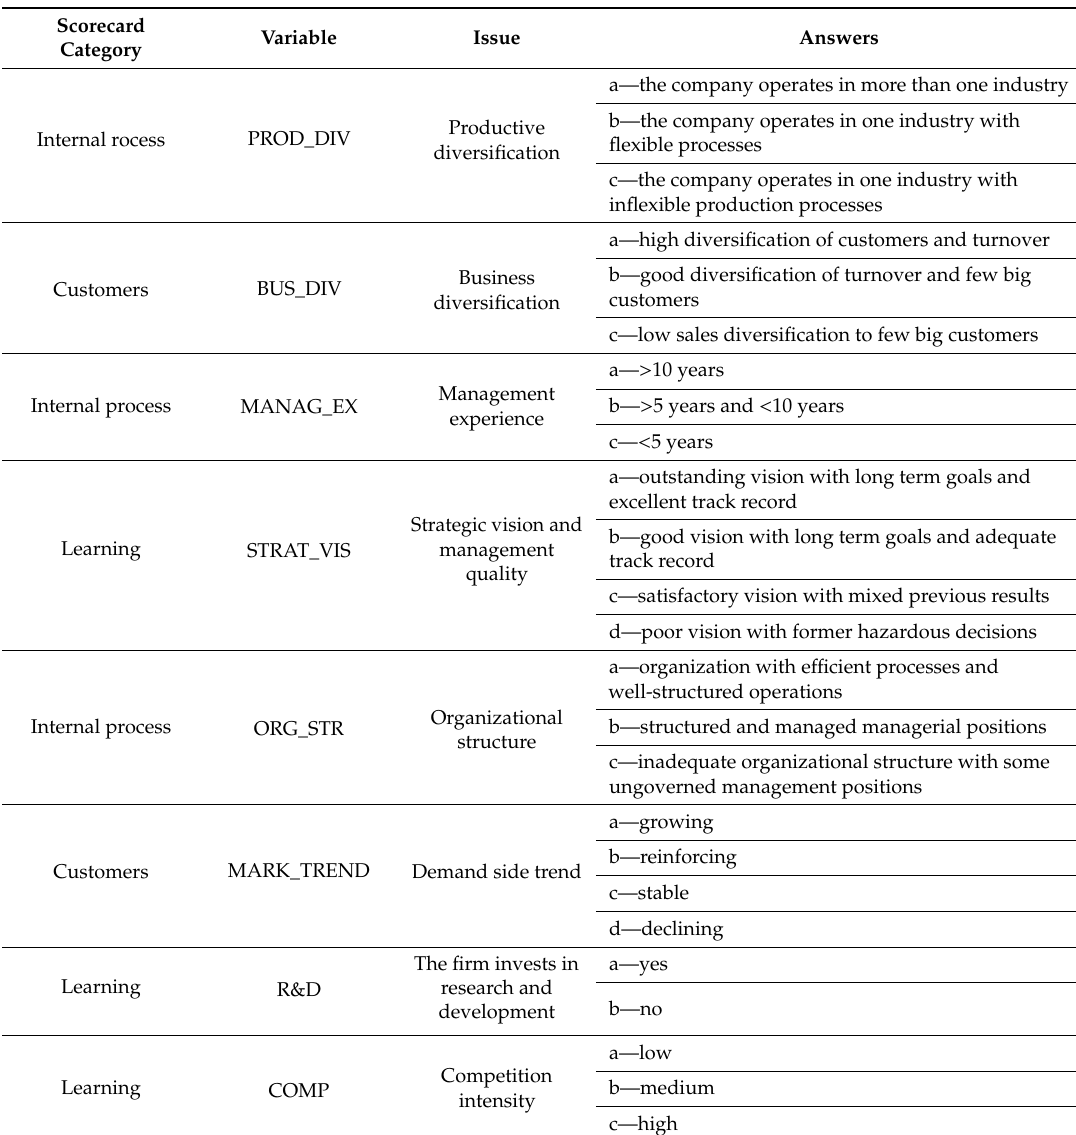
Table 2. Strategic and Business